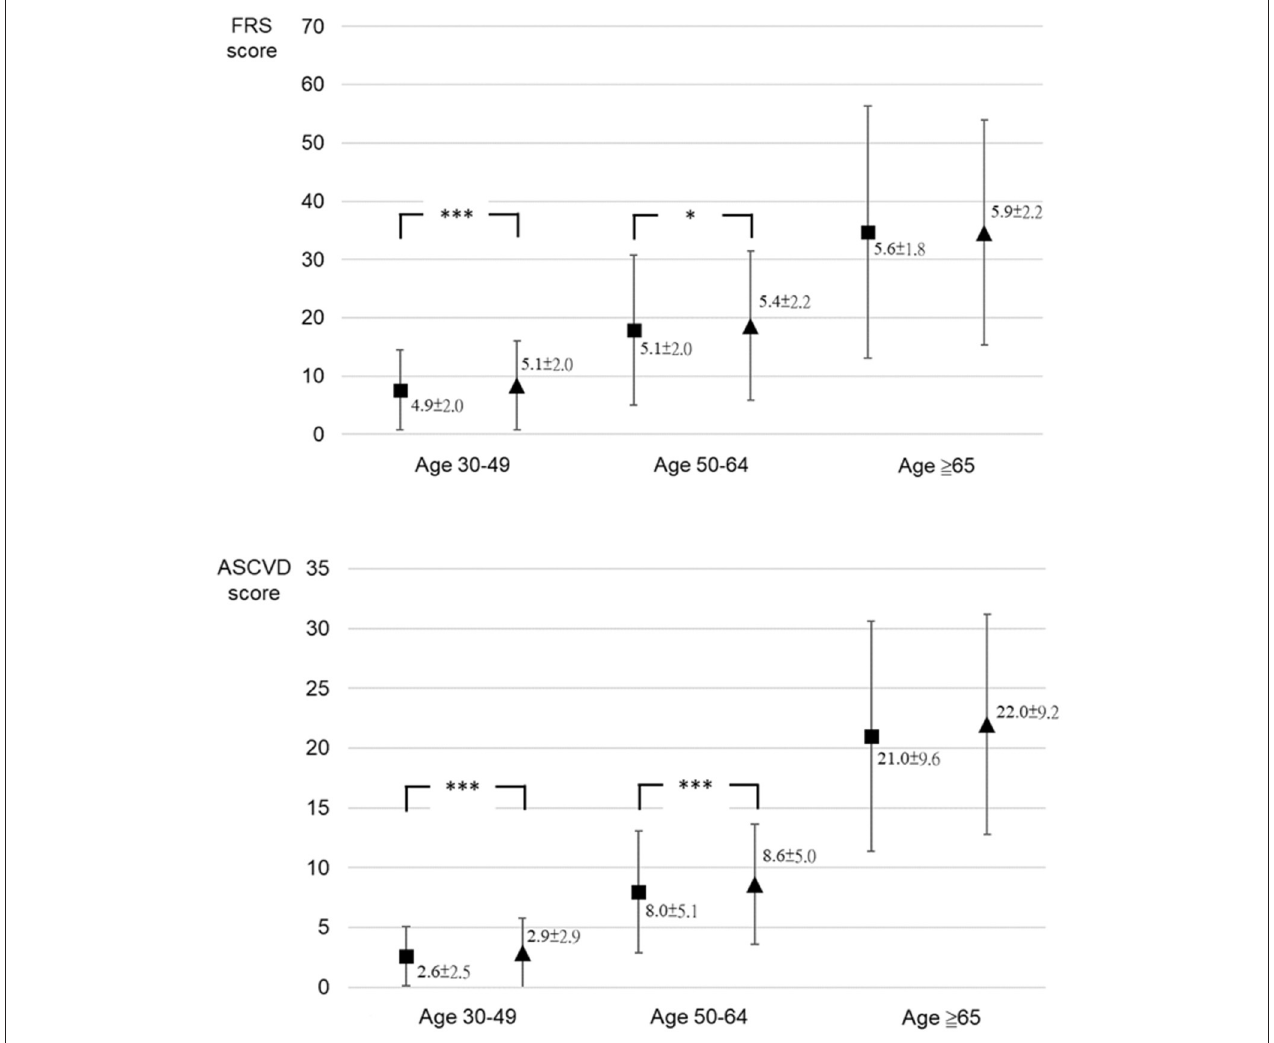
FIGURE 2 | The comparison between cardiovascular risk score of the Framingham Risk Score and ASCVD Risk Estimator at the first and second medical checkups by age group. Framingham Risk Score (FRS) score: cardiovascular risk score (%) calculated using the FRS (2008); Atherosclerotic cardiovascular disease (ASCVD) score: cardiovascular risk score (%) calculated using ASCVD Risk Estimator (2013). *** p < 0.001; * p <